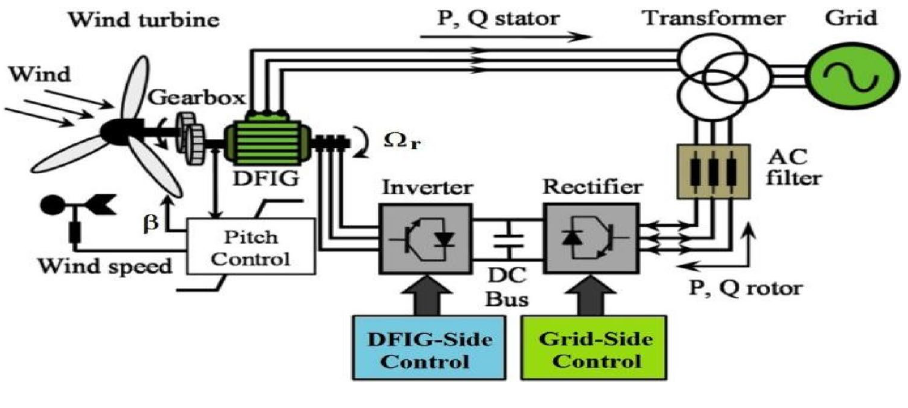
Figure 1. WECS based on the